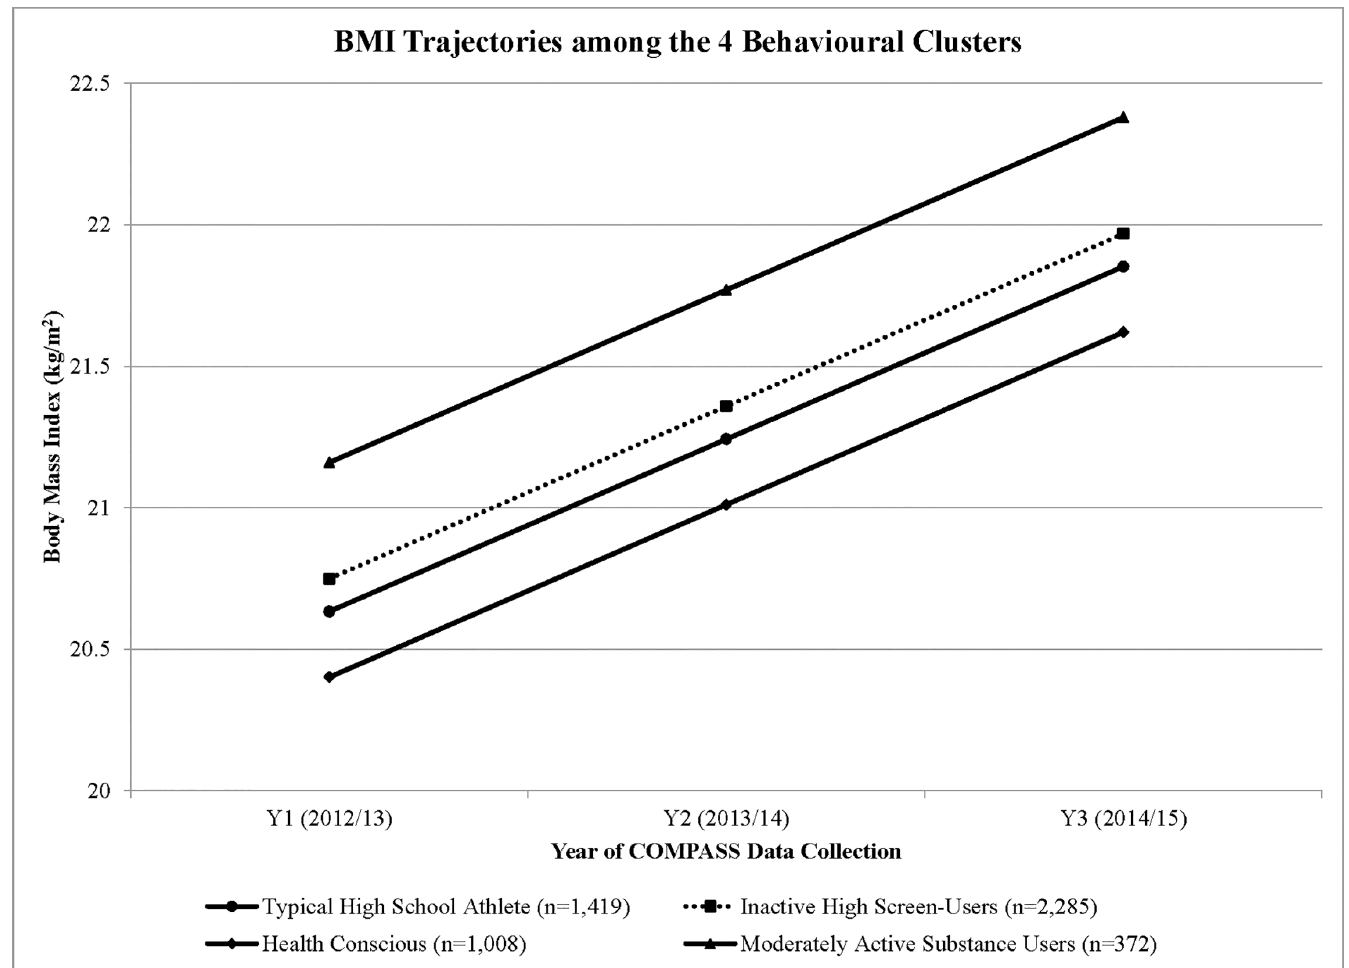
Fig 3. Model-based predicted BMI trajectoriesof the 4 behavioural clusters from youth participating in Y 1 to Y 3 of the COMPASS study in Ontario, Canada.